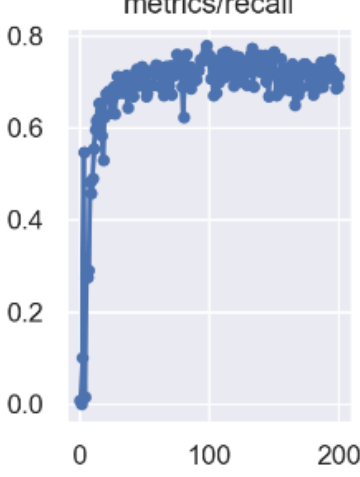
Figure A7. The changes of recall of YOLOV5m.